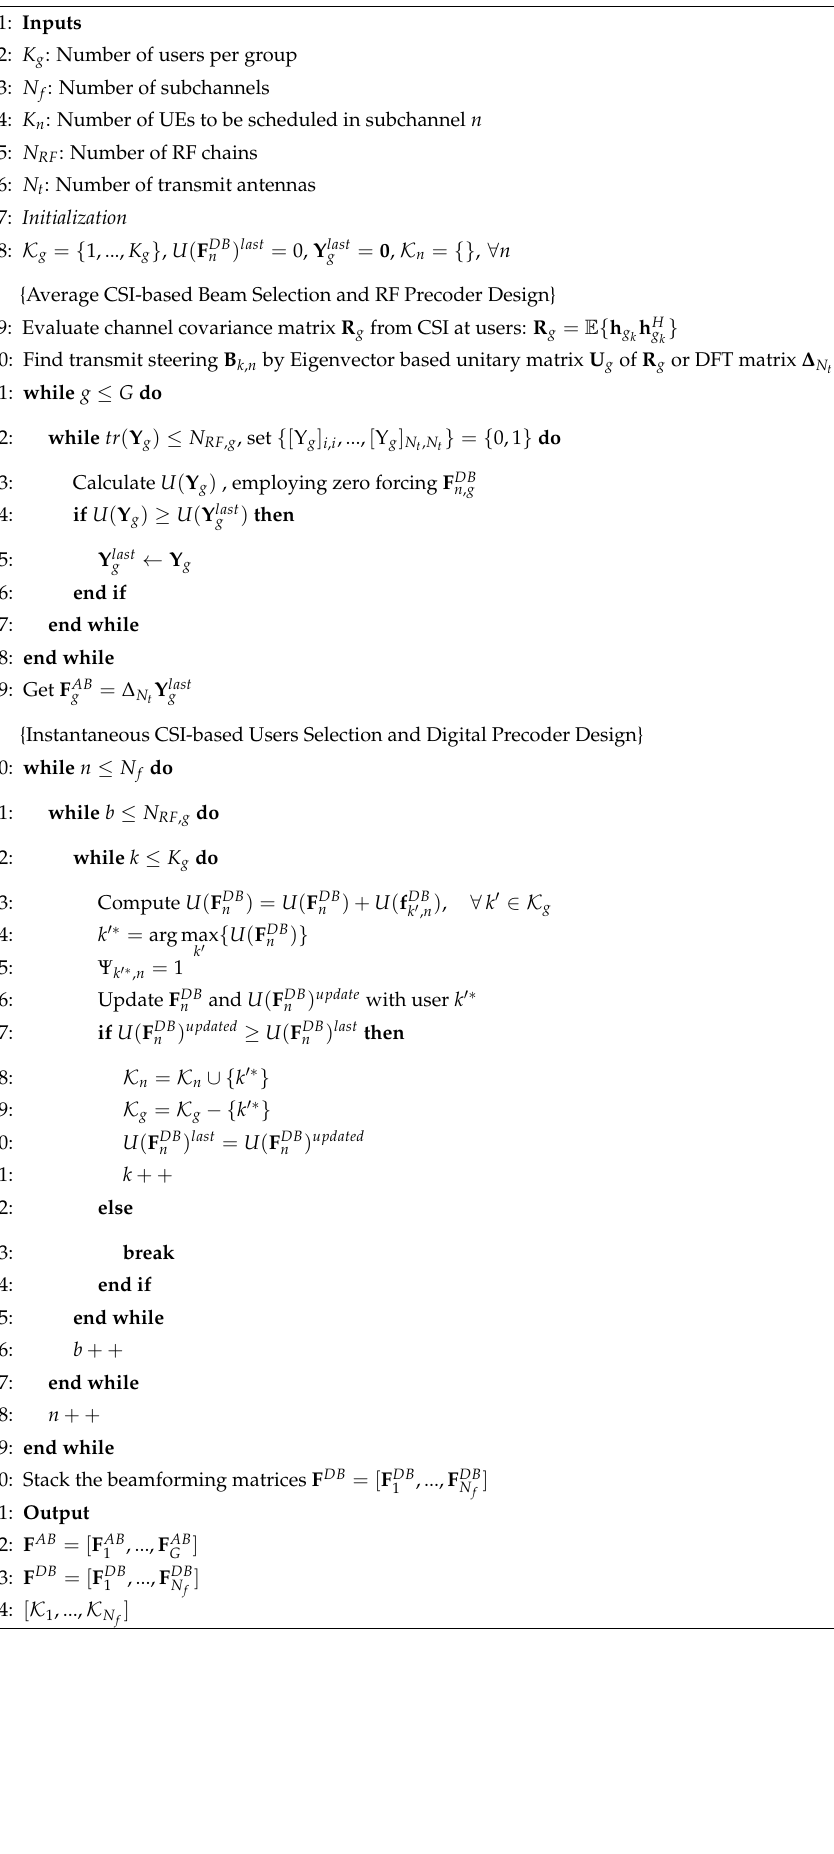
Algorithm 1 Joint Resource Allocation and Hybrid Beamforming Design